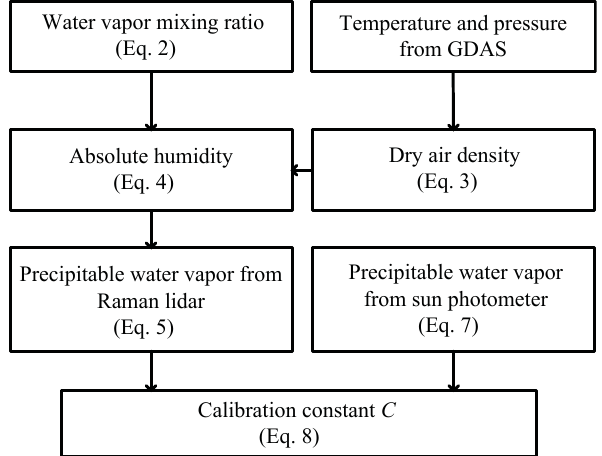
Figure 4. (a) Comparison of daytime precipitable water vapor (PWV) measured with radiosonde (RS) and sun photometer (SPM). (b) Relative error of PWV values from SPM measurements.